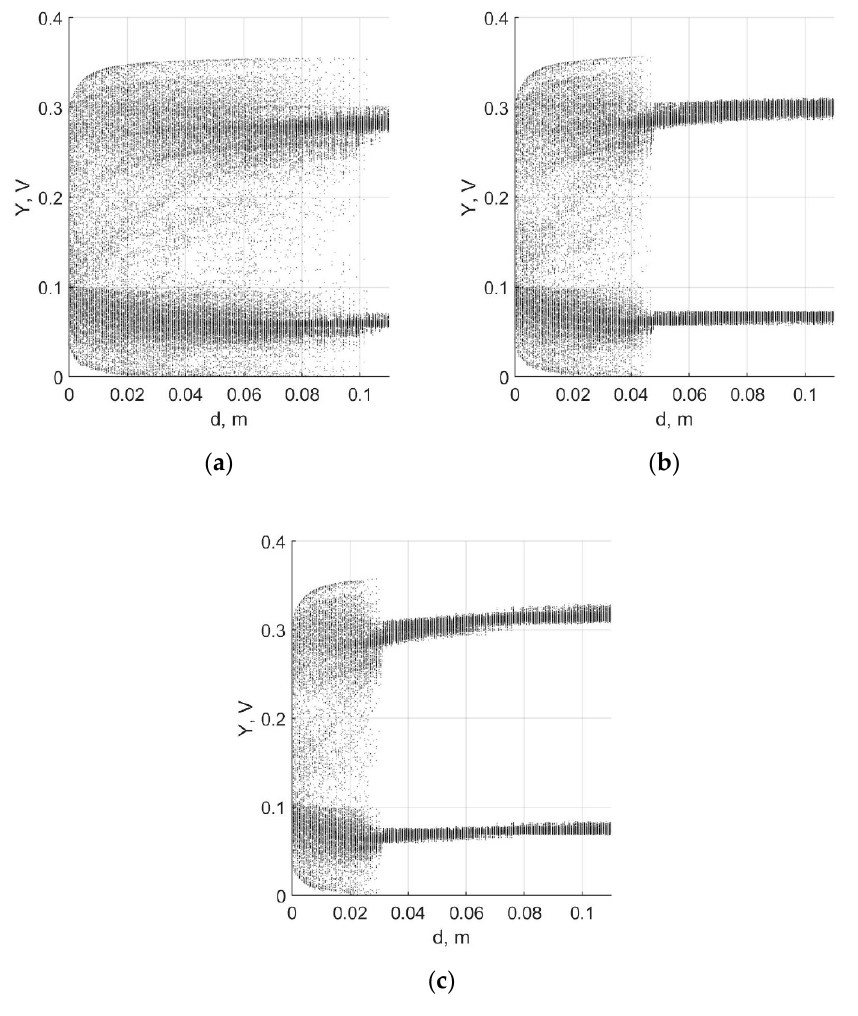
Figure 18. Bifurcation diagrams obtained for different values of the free parameter: ( a ) V n = 1.51 V; ( b ) V n = 1.595 V; ( c ) V n = 1.65 V.